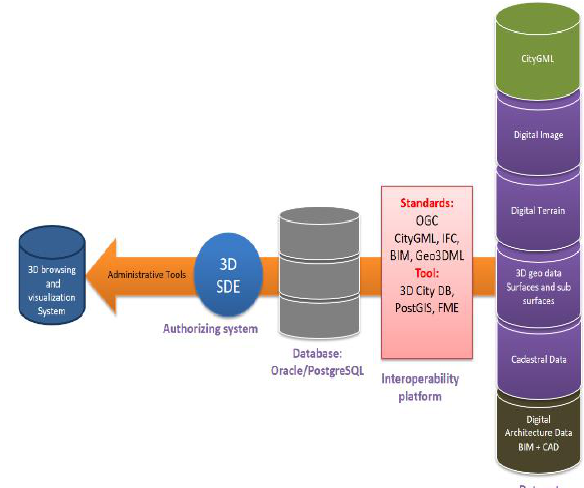
Figure 5. Developing framework for surfaces and subsurface spatial objects within the 3D